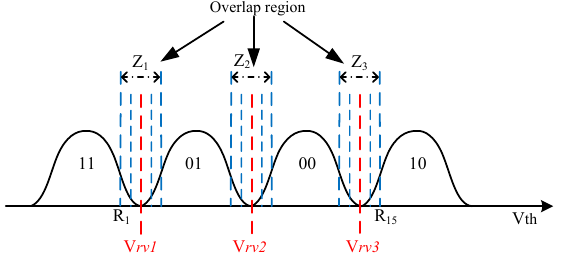
Figure 2. Illustration of 15-level uniform sensing quantization for multi-level cell (MLC) flash